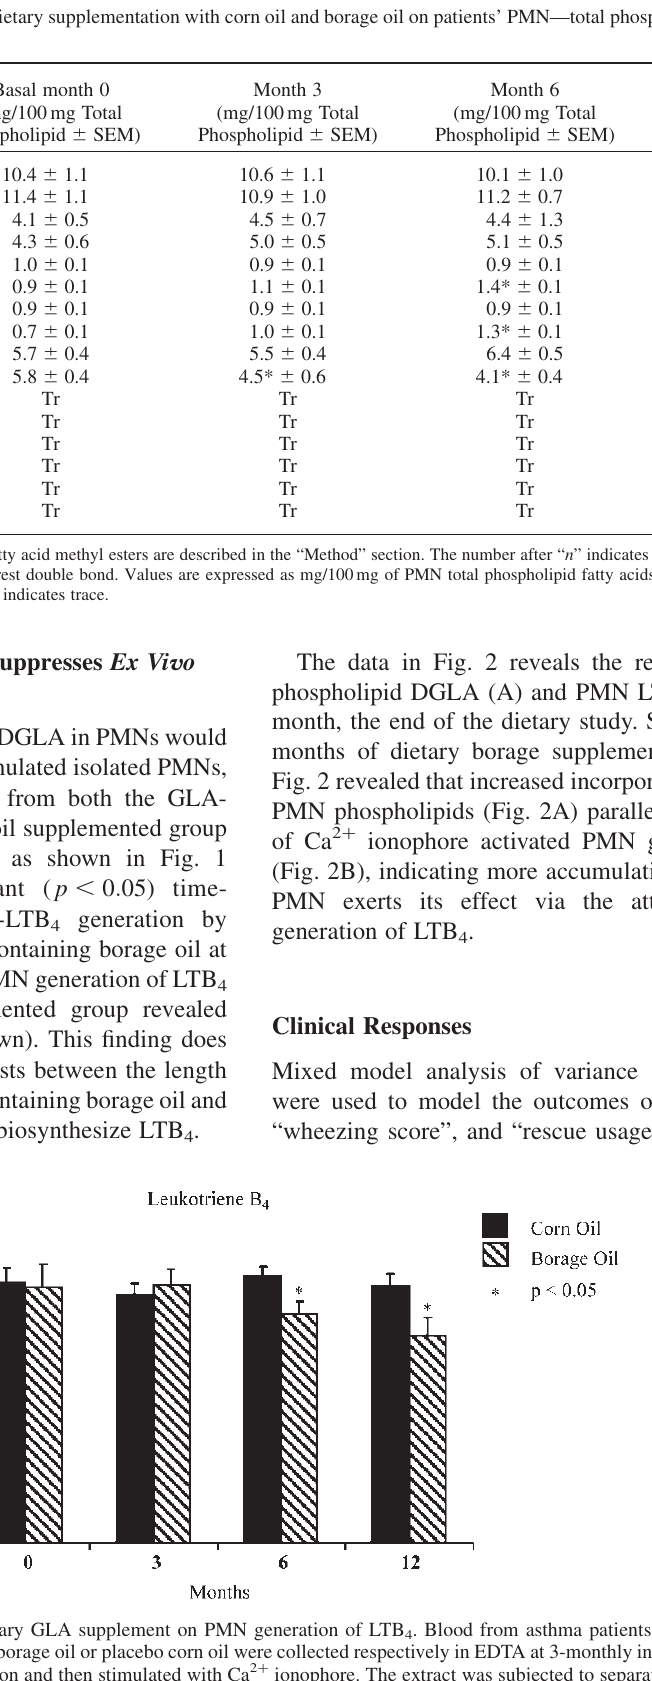
TABLE III Time-dependent influence of dietary supplementation with corn oil and borage oil on patients’ PMN—total phospholipid unsaturated fatty acids level